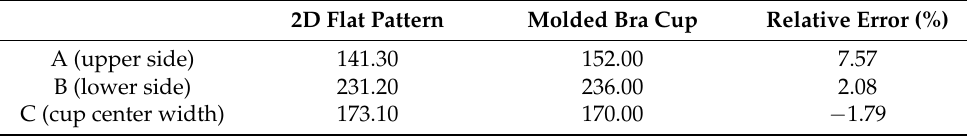
Table 2. Results of error verification of the 3D molded bra cup (Unit: mm, %).